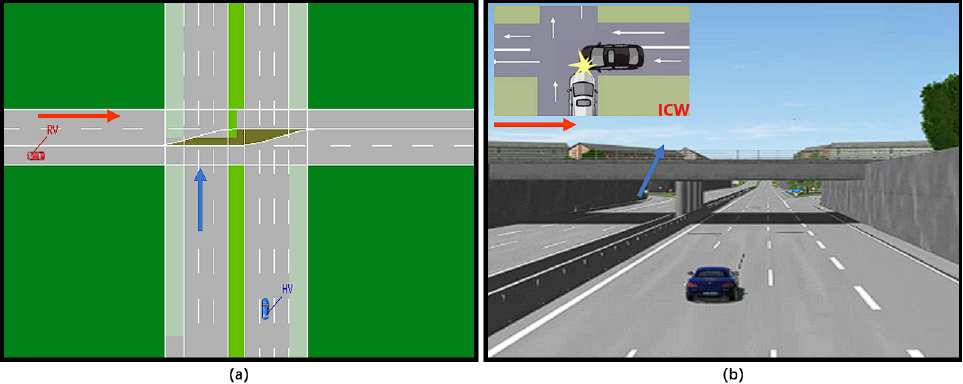
Figure 17. ICW test: ( a ) Top view, ( b ) Main view with unsuitable warning in VTD